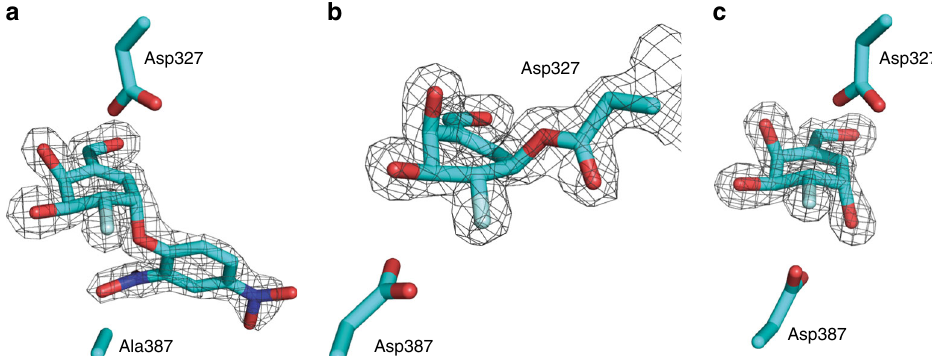
Fig. 6 Structure of Tm GalA in complex with 4 . a Structure of Tm GalA mutant D387A in complex with intact 4 . b Structure of Tm GalA in complex with 2- deoxy-2- fl uorocarbagalactose fragment of 4 covalently bound to the nucleophile D327. c Structure of Tm GalA in complex with hydrolyzed inhibitor 6 . The maximum likelihood/ σ A weighted 2 F obs − F calc electron density map is contoured at 1.5 sigma in all cases. The catalytic residues D327 and D387 (or D387A) residues are shown